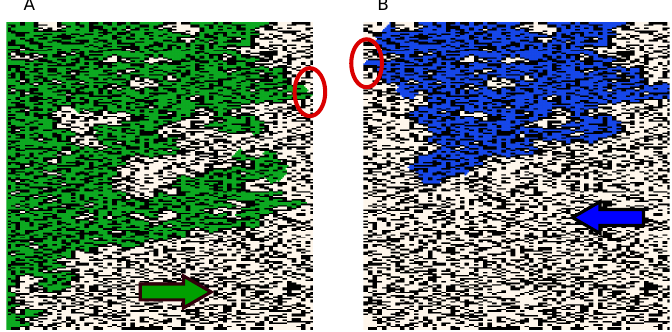
Figure 1. An example of the shortest path calculation routine. ( A ) Left lateral side of the myocardial slab is marked as “activated” and multiple dilation operations are performed. Wave propagates from left to right. Green color indicates activated cells, white and black indicate non-activated cells and fibrosis elements respectively. Red ellipse indicates the very first activated cell on the right side. ( B ) Starting from the right side activated cell, a number of the dilation operations is performed until any of left side cells is activated. This number N of dilation iterations is taken as the length of the shortest propagation path for the given fibrosis texture. Here, blue color shows activated cells. Red ellipse indicates the very first activated cell on the left